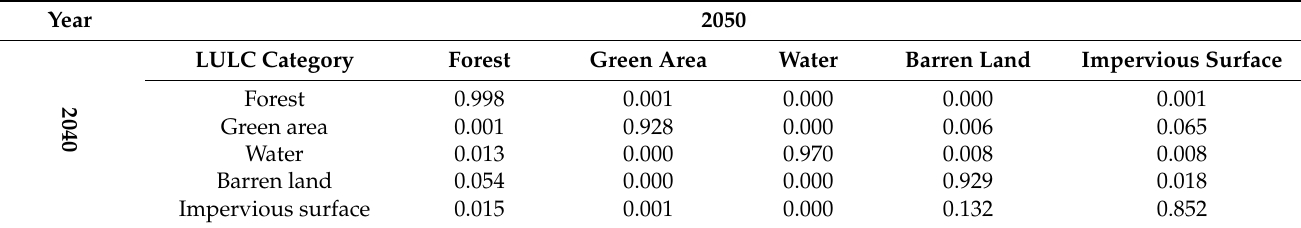
Table 12. Transition matrix from 2040–2050.